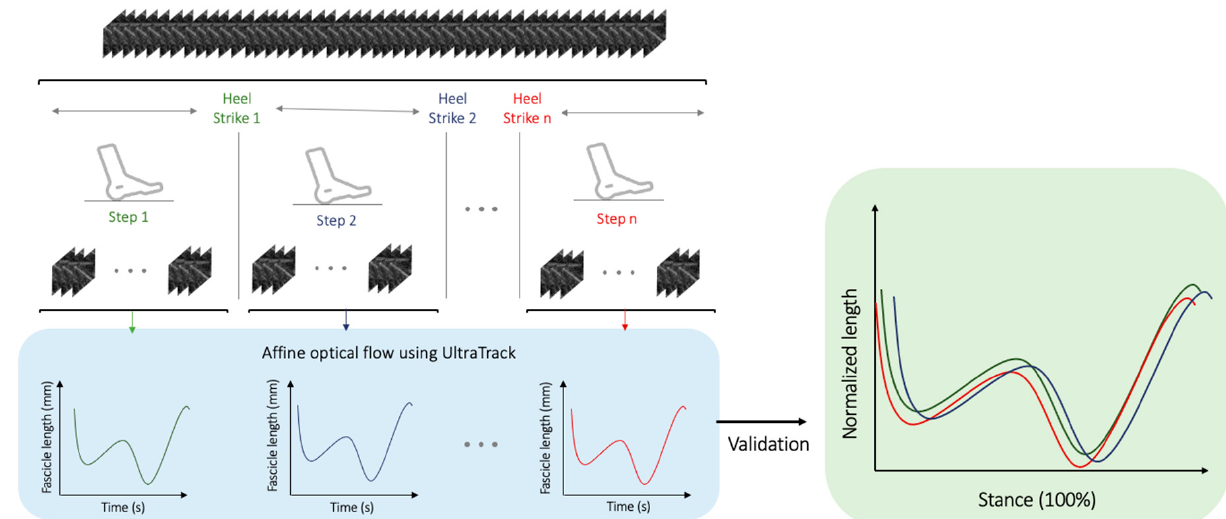
Figure 3. Illustration of high-level pipeline showing labeling used in this study. The continuous B-mode ultrasound recordings are segmented based on prerecorded heel strikes. The individual chucks are then processed using the affine optical flow algorithm of UltraTrack [25] to extract the fascicle lengths in millimeters (mm) across time in seconds (s) (in the lower left box). Each segmented sequence has many fascicle lengths (on average 130 frames in each segmented sequence), which form the fascicle lengths over time waveforms (left blue box). Finally, to validate the accuracy of the labeling methodology, the extracted individual segments of fascicles are plotted on top of each other over the stance phase (in the right box) following the approach proposed by Lai et al. [37].